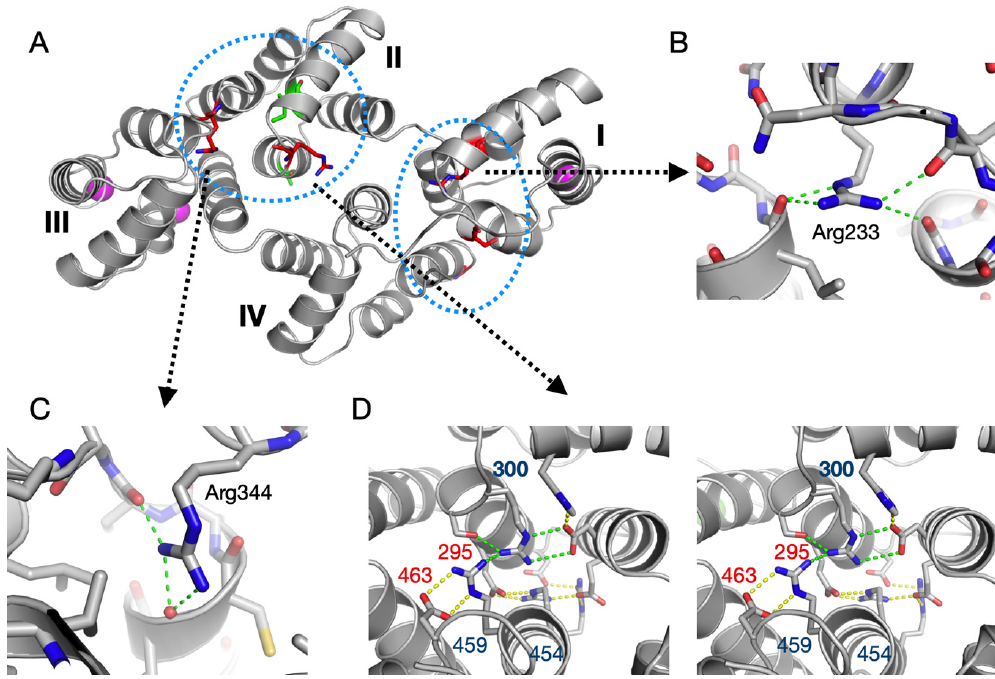
Figure 6. Location of ALS mutations and variants in the AnxA11 structure. ( A ) The five ALS mutations (see text) are highlighted in red and the two rare variants in green. The two 3D clusters of mutations/variants are shown with blue dashed circles. One cluster lies in domain II, possibly affecting folding and/or interactions with domain III. The other cluster is at the interface between domains I and IV, i.e. the N and C terminus of the AnxA11 core structure. ( B ) Arg233 (corresponding to the human R235Q mutation) makes four contacts to carbonyl groups at the C-terminal end of domain I helices B and E. With its buried positive charge, Arg233 interacts with the negative helix dipole from both helices. ( C ) Arg344 (corresponding to R346C) similarly caps helix B of domain III. ( D ) An extended salt bridge network exists between domains II (top) and IV (bottom) (stereo view). Arg300 (corresponds to R302C) is central in this network. The charged residues with numbers indicated are fully conserved in all rat Anxs (Arg, blue; acidic, red). ∆∆ G predictions for the five mutations on the SDM server [72] indicate decreased stability for all mutations except S229R. Hence, the a ff ected residues may be important for correct folding and / or stability of AnxA11. Recent functional characterisation of the AnxA11 ALS mutation R235Q shows that the mutant protein is prone to aggregation and sequesters FL-AnxA11. This in turn abolishes the binding to calcyclin [35]. In addition, two rare missense variants, A293V and I307M, were recently discovered in the Chinese Han population [34]. These residues are located in domain II (Figure